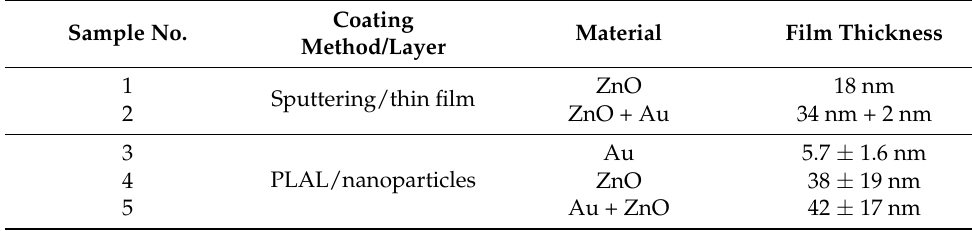
Table 1. Coating parameters. Sample No.